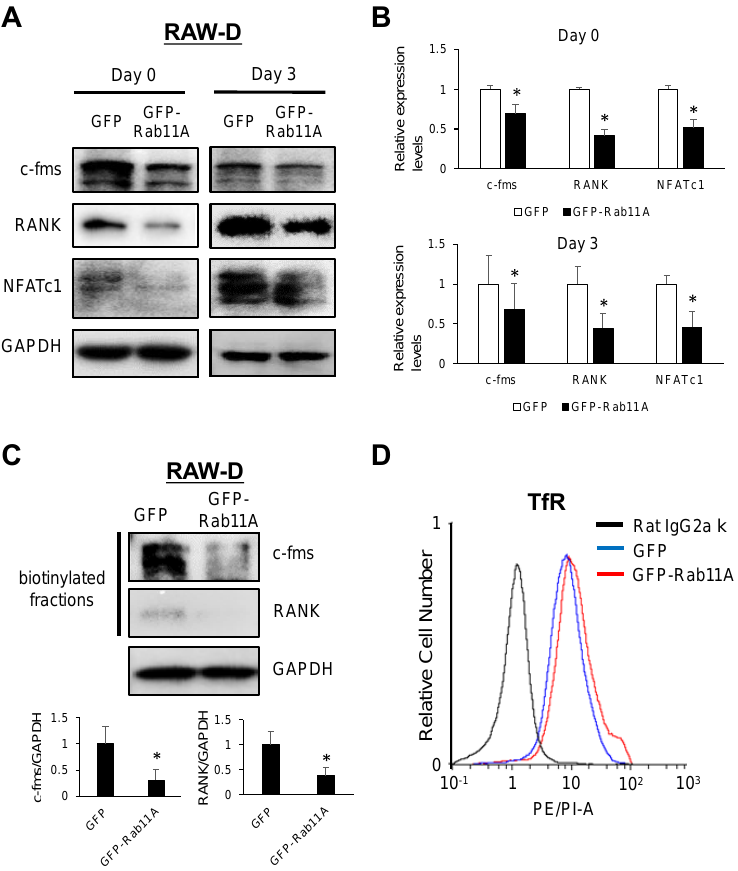
Figure 7. The e ff ects of Rab11A overexpression on cell surface levels of c-fms and RANK receptors in RAW-D cells upon RANKL stimulation. ( A ) The endogenous levels of c-fms, RANK, and NFATc1 in RAW-D cells expressing GFP (control) or GFP- Rab11A following RANKL stimulation for 0 or 3 days. ( B ) Quantitative analyses of Western blot for c-fms, RANK, NFATc1. GAPDH was used as an internal control. * p < 0.05. ( C ) Upper: The biotinylated fractions were subjected to immunoblotting with anti-mouse c-fms and anti-mouse RANK antibodies, and WCLs were subjected to immunoblotting with GAPDH-HRP antibody as a loading control in RAW-D cells expressing GFP (control) or GFP-Rab11A. Lower: Quantitative analyses of Western blot for c-fms, RANK. ( D ) Flow cytometric analyses of TfR were done using RAW-D cells expressing GFP (control) or GFP-Rab11A. Data are the representative of three independent